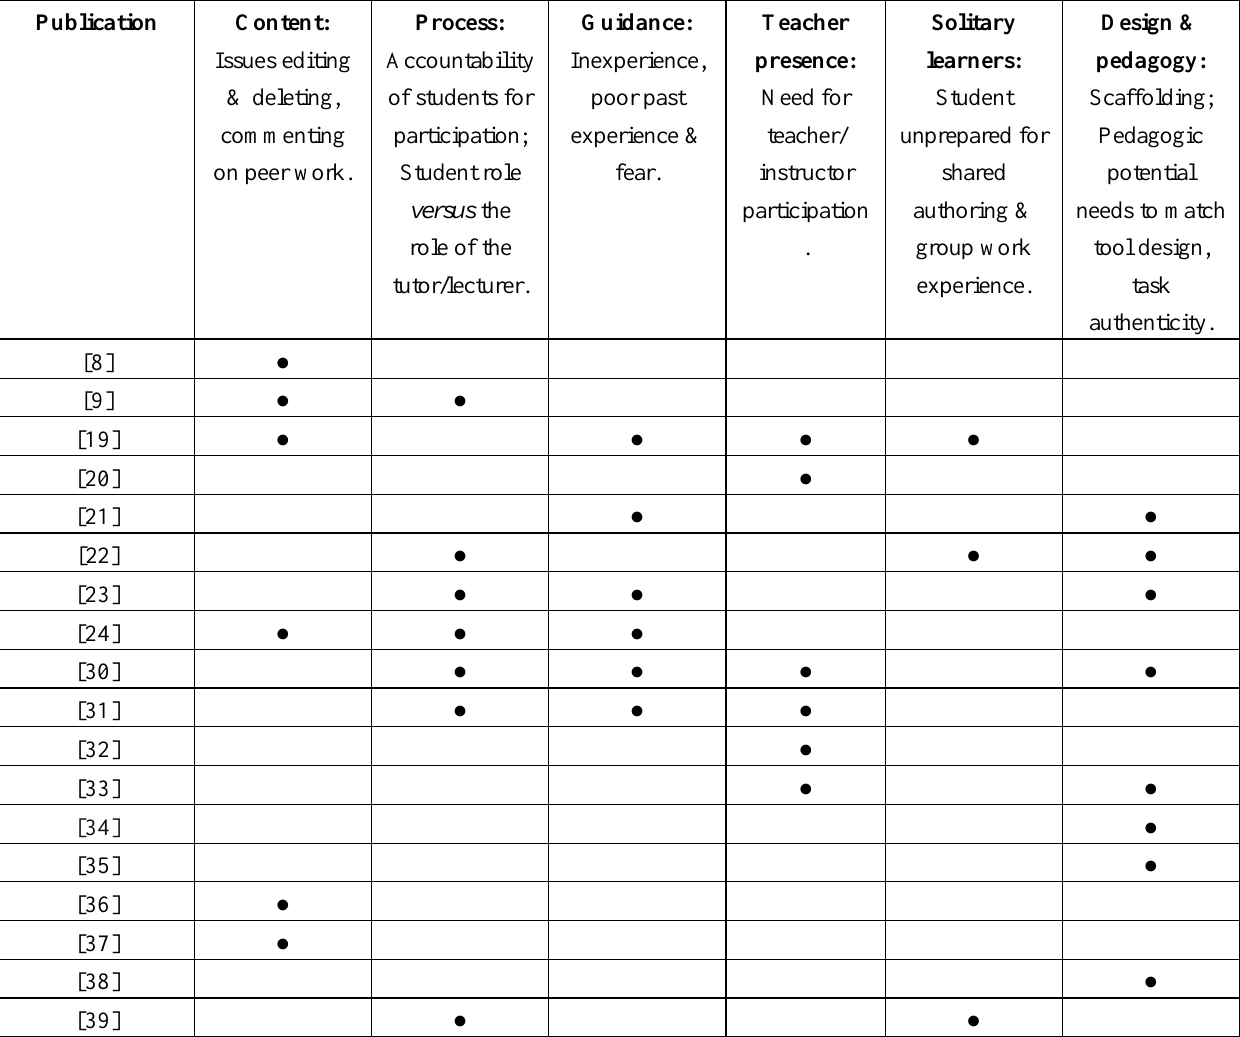
Table 2. Problems and challenges for the use of Web 2.0 tools by students in higher education.